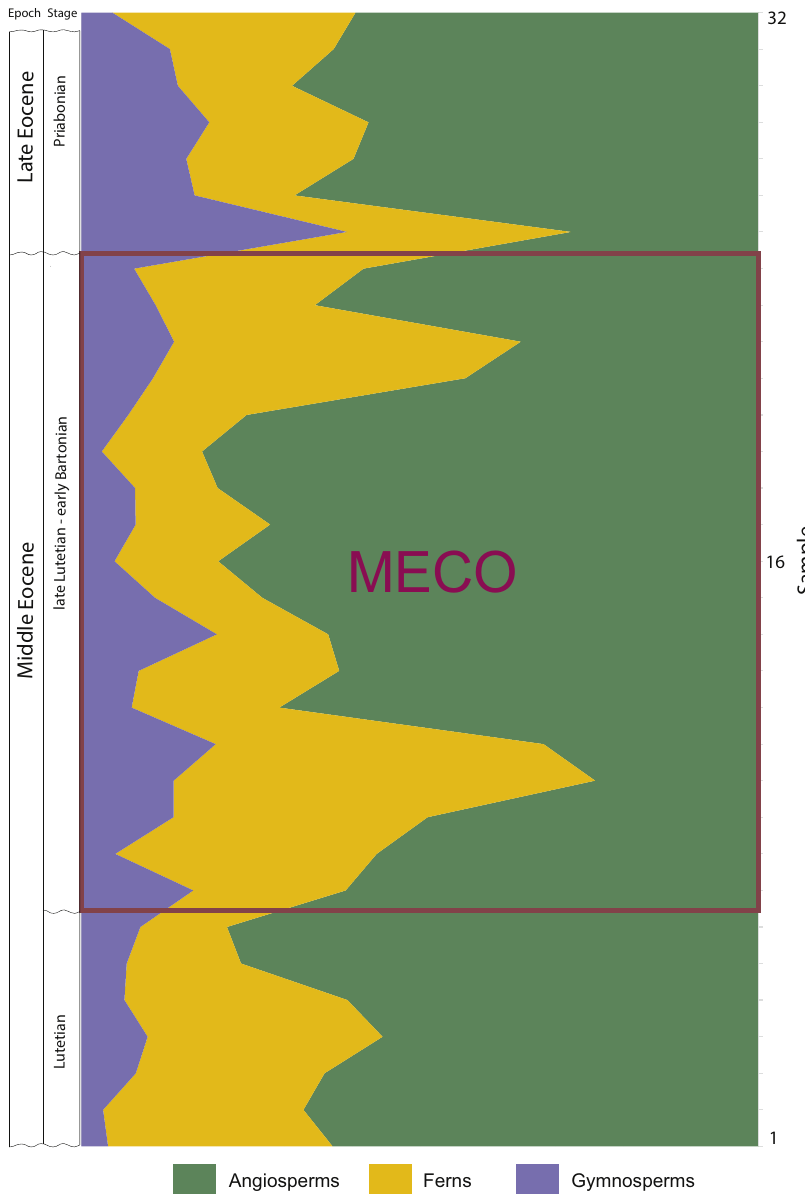
Fig. 5 Relative frequency of the major plant groups through time. Note the peak in abundance of ferns at the onset and end of the